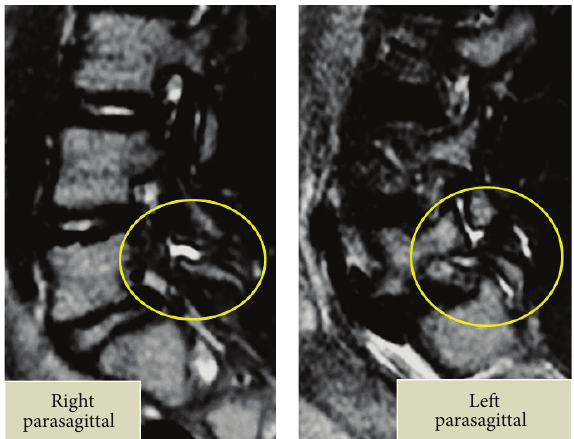
Figure 4: Sagittal short tau inversion recovery magnetic resonance imaging (STIR-MRI) of Case 1. Note the effusion in the pars defects and in the adjacent facet joints. These findings correspond with communicating synovitis.